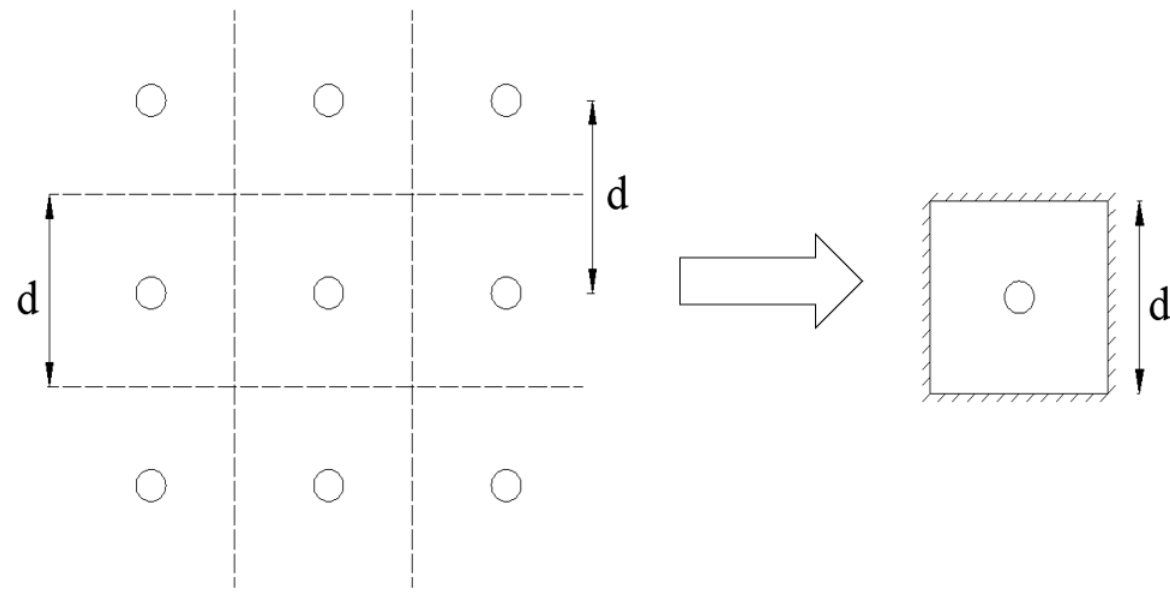
Appl. Sci. 2023 , 13 , 3633 Figure 3. Square arrangement of siphon drainage holes. Figure 3. Square arrangement of siphon drainage holes.